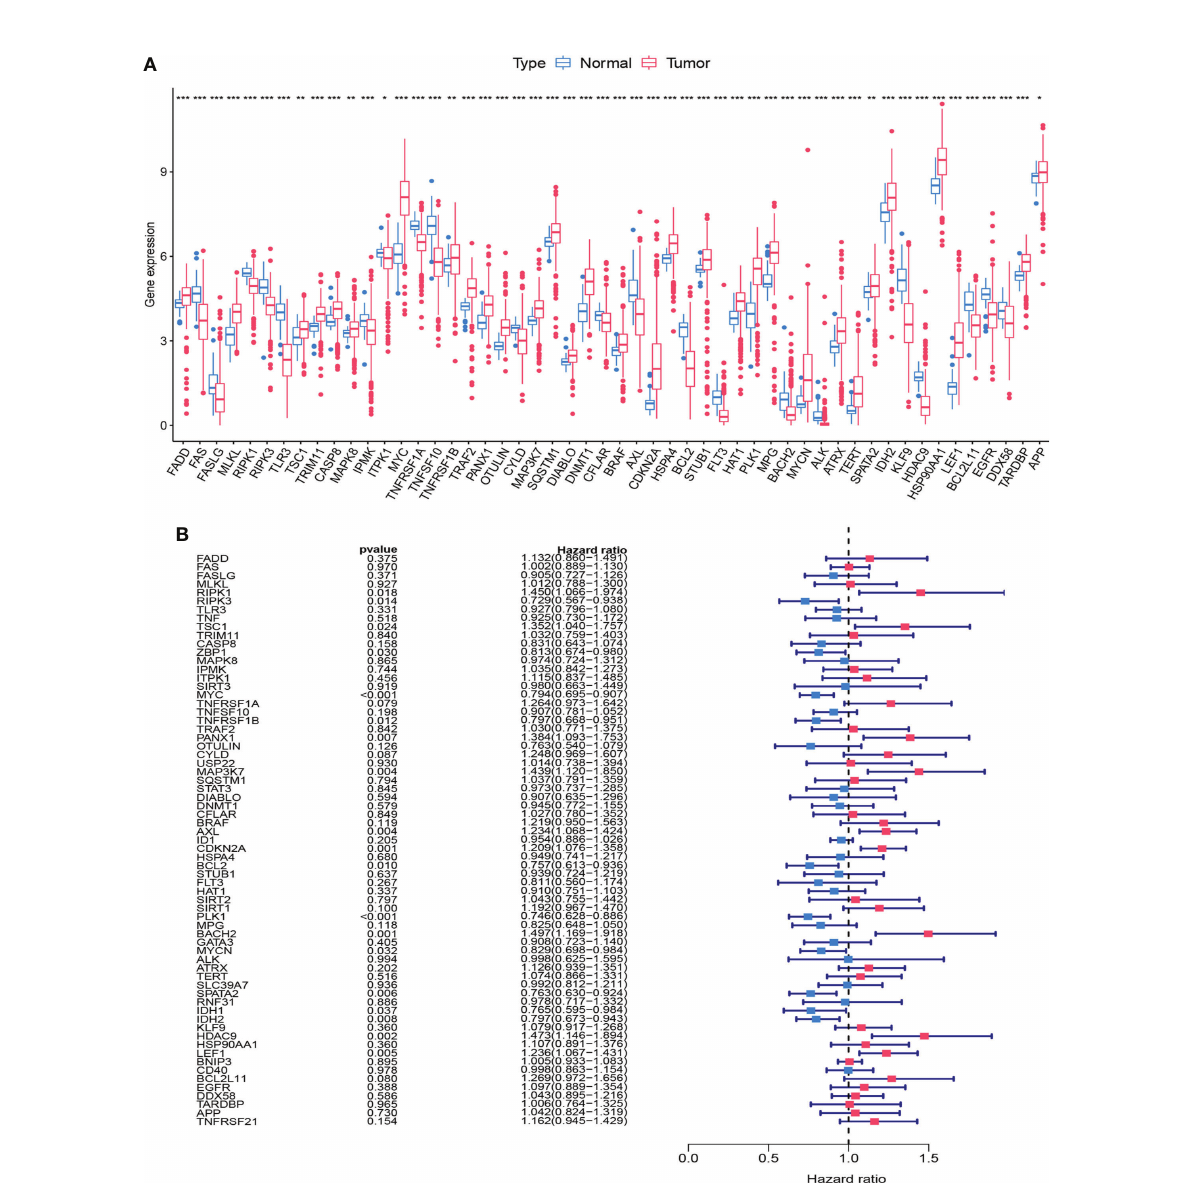
FIGURE 1 Expression and survival information of necroptosis-related genes (NRGs) in colorectal cancer. (A) Expression distribution of 67 NRGs in normal and cancer tissues. (B) Univariate COX analysis of 67 NRGs. ***P < 0.001; **P < 0.01; *P <